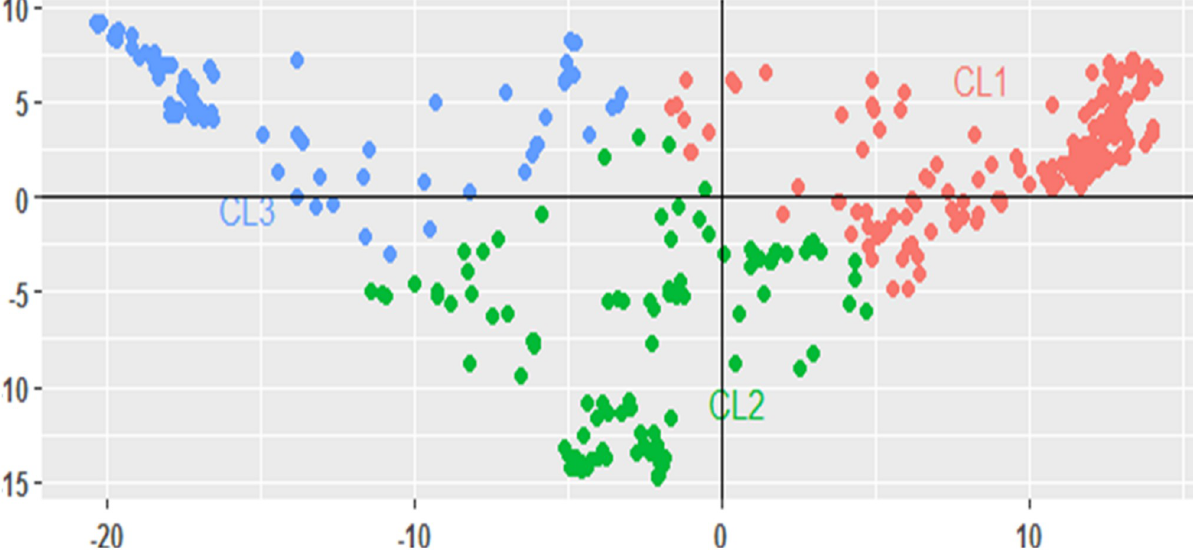
Fig 6. A bi-plot of the first two principal components (PC1 and PC2) of 357 cowpea genotypes, using 6 498 SNP markers. Each color corresponds to population structuring and grouping.